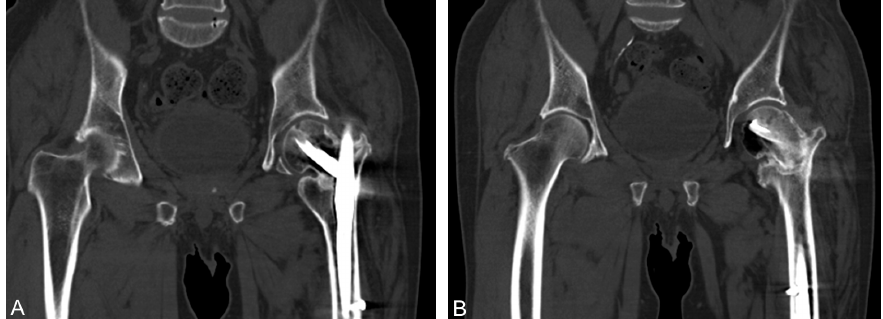
Figure 5. ( A , B ) CT performed before completion of 4-month teriparatide treatment showed fracture union with bridging callus formation.